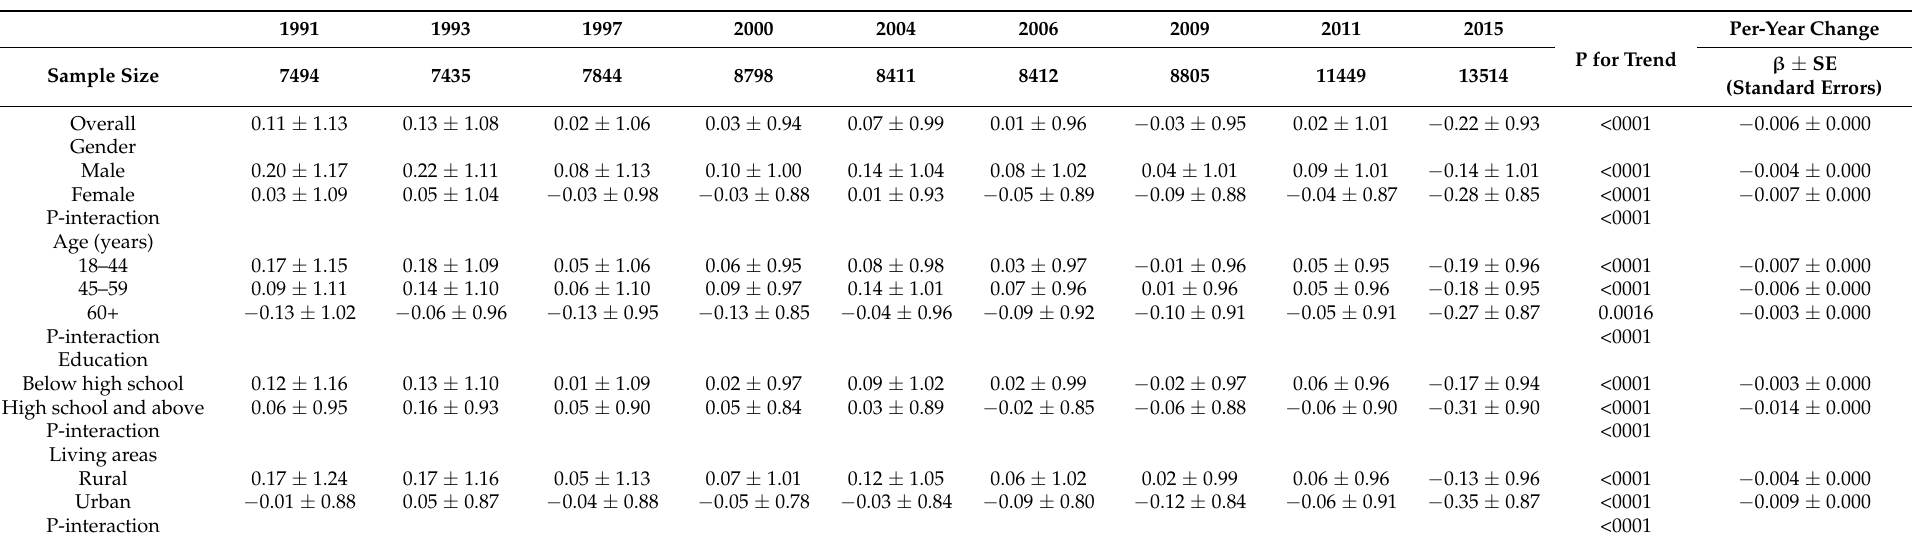
Table 3. Trends for the southern pattern score among Chinese adults from 1991 to